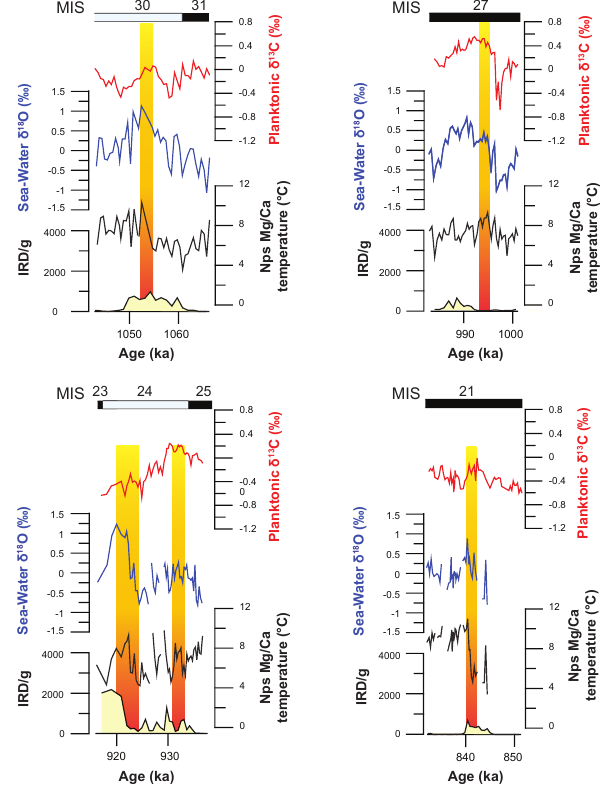
Figure 3. Comparison between Mg / Ca palaeotemperature, δ 18 O sw , planktonic δ 13 C and IRD/g for Site U1314 during specific